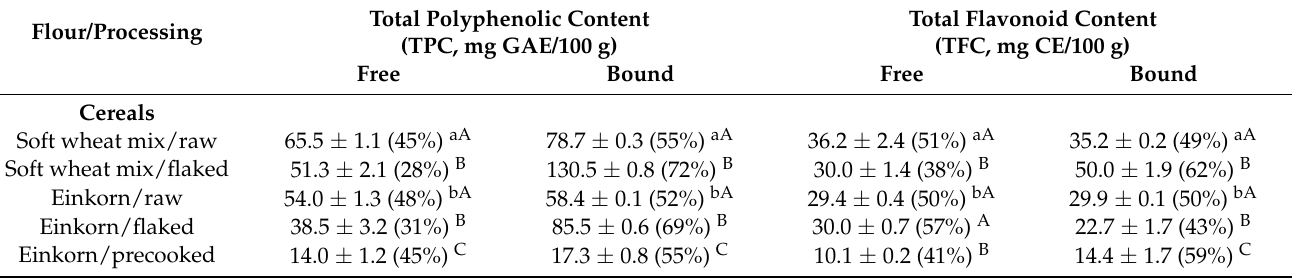
Table 3. Free and bound polyphenolic and flavonoid contents in the hydrophilic extracts, reported as mean ± SD ( n = 27). Values in brackets represent the contribution of free and bound fractions to the total polyphenolic (TPC) and flavonoid (TPF) contents, that can be calculated as sum of the two